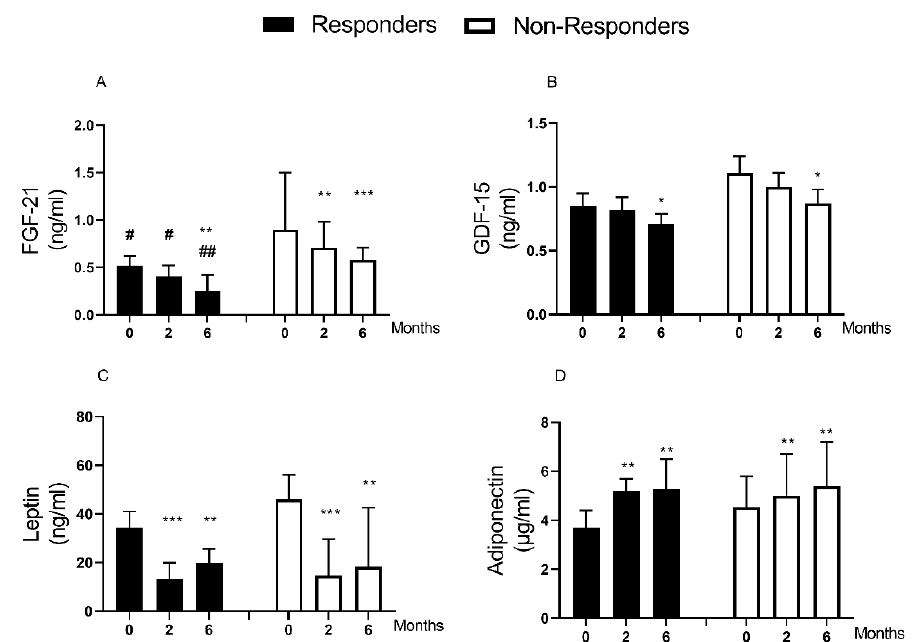
Figure 2. Change in plasma biomarkers after weight loss and remission of type 2 diabetes. Data are presented as median (IQR) except for GDF-15 (mean ± SEM). ( A ): FGF-21, ( B ): GDF-15, ( C ): Leptin, ( D ): Adiponectin. There were 29 participants (12 responders/17 non-responders) studied at baseline, 2, and 6 months post-weight loss. FGF-21 Data for one responder is missing (n = 11). * p < 0.05 vs. 0 month, ** p < 0.01 vs. 0 month, *** p < 0.001 vs. 0 month. # p < 0.05 vs. non-responders, ## p < 0.05 vs. non-responders.